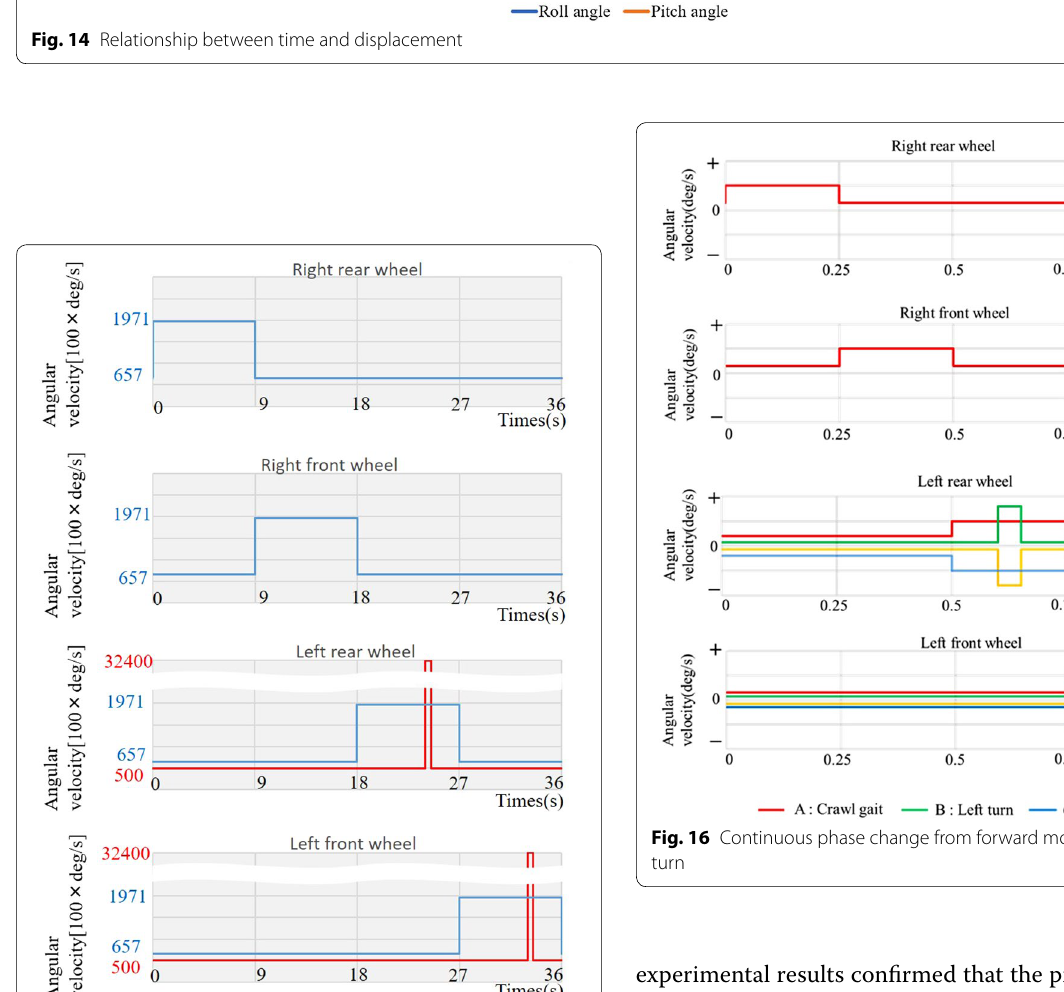
experimental results confirmed that the prototype model can pivot turn without falling.